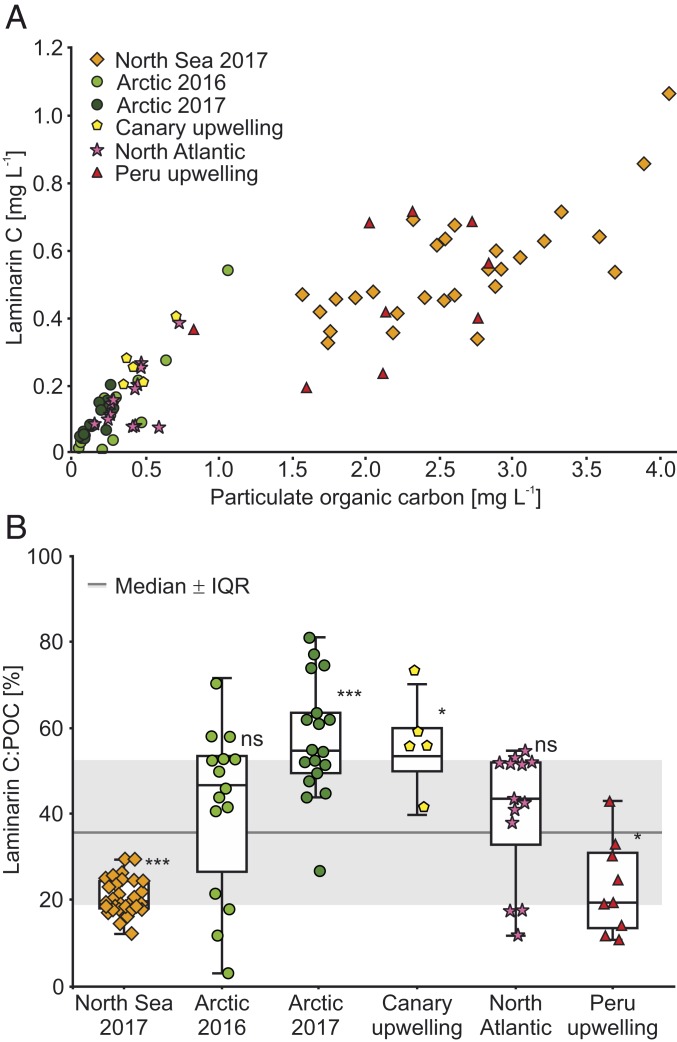
Laminarin is a substantial component of particulate organic carbon in diverse oceanic regions. (A) The overview scatter plot comprises all regions where POC was measured. (B) The box plot depicts each individual dataset against the overall median value of Laminarin C:POC. Significant deviations from the overall median and its standard deviation (SD) in gray were tested using the Kruskal–Wallis test (***P < 0.001; *P < 0.05; ns, not significant).